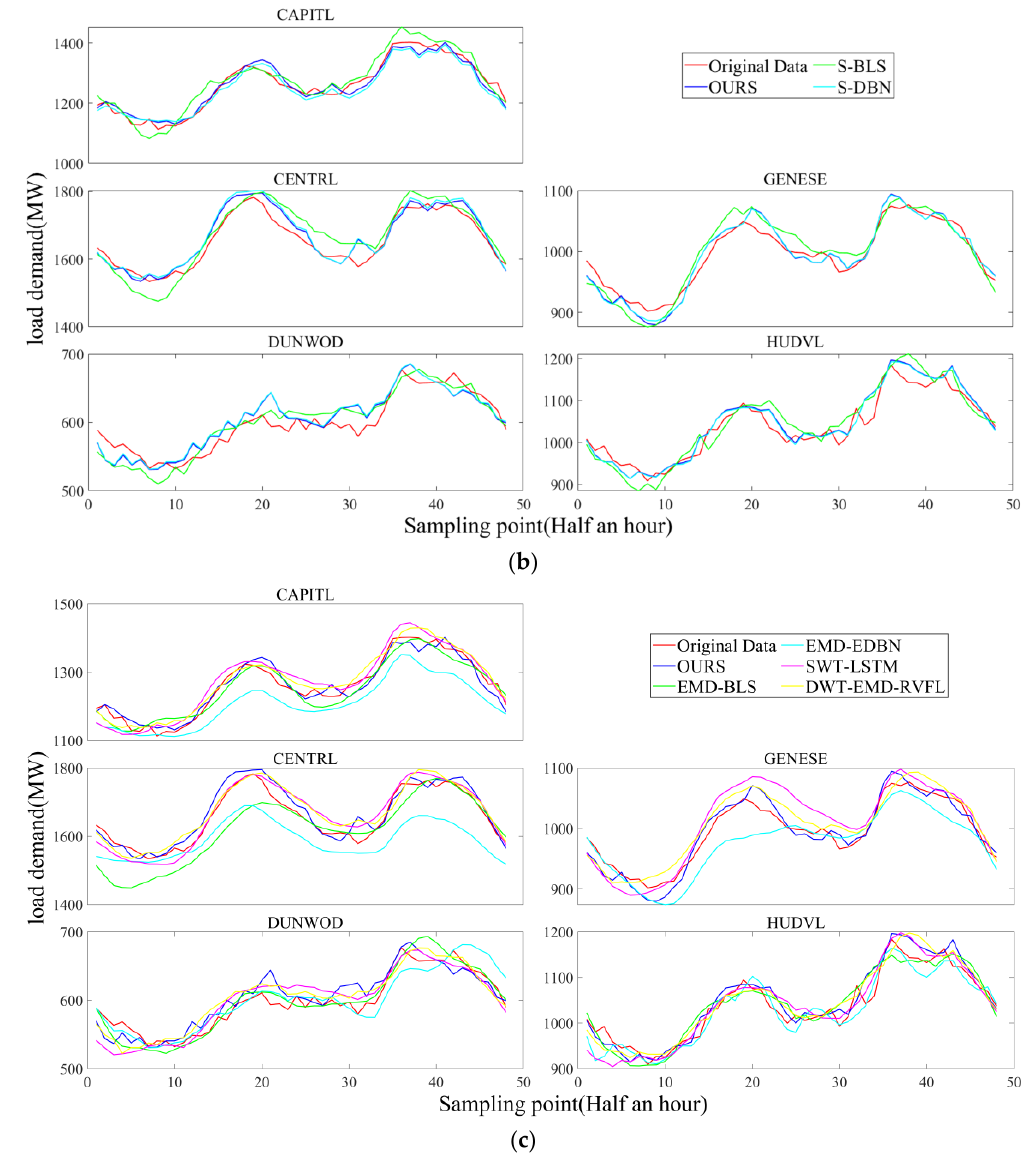
Figure 13. ( a ) The prediction curve of the comparison with separate neural network models; ( b ) the prediction curve of the comparison with other ensemble models; ( c ) the prediction curve of the comparison with other hybrid models.